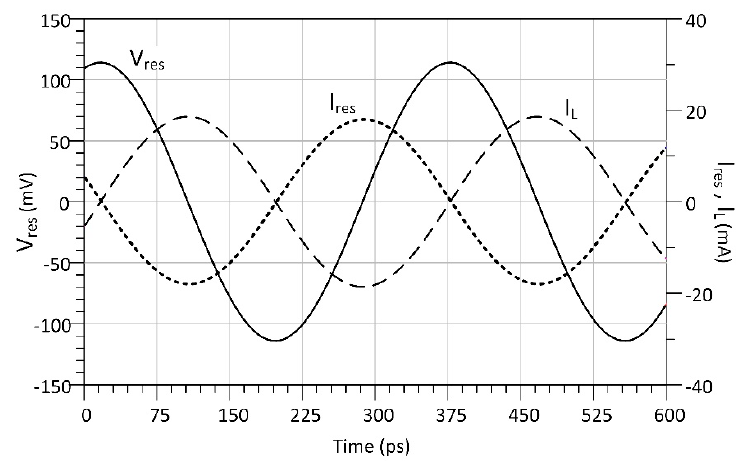
Figure 14. Simulated currents I RES in the resonating capacitance C RES and in the active inductor I L , together with the voltage V RES at the corresponding node (see Figure 10b).